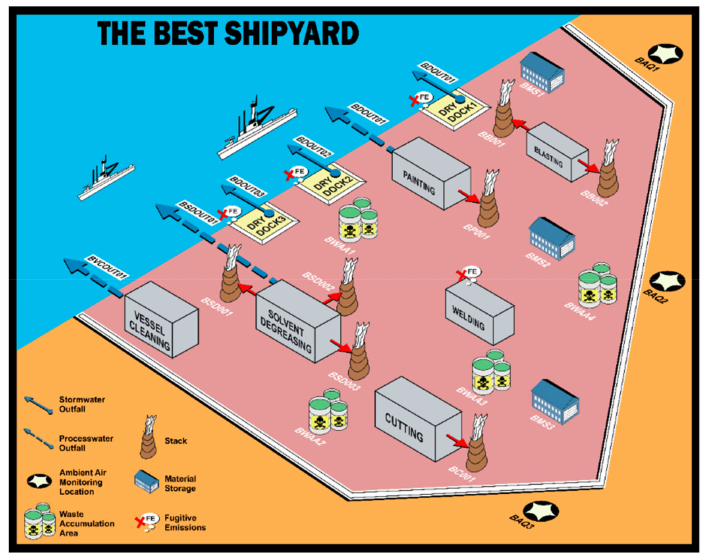
Figure 2. The best shipyard–A hypothetical layout for